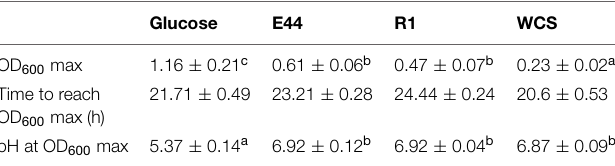
TABLE 1 | Parameter values of Bacteroides fragilis cultures grown in the presence of glucose, EPS E44, EPS R1 or without carbohydrate source added (WCS) at OD 600